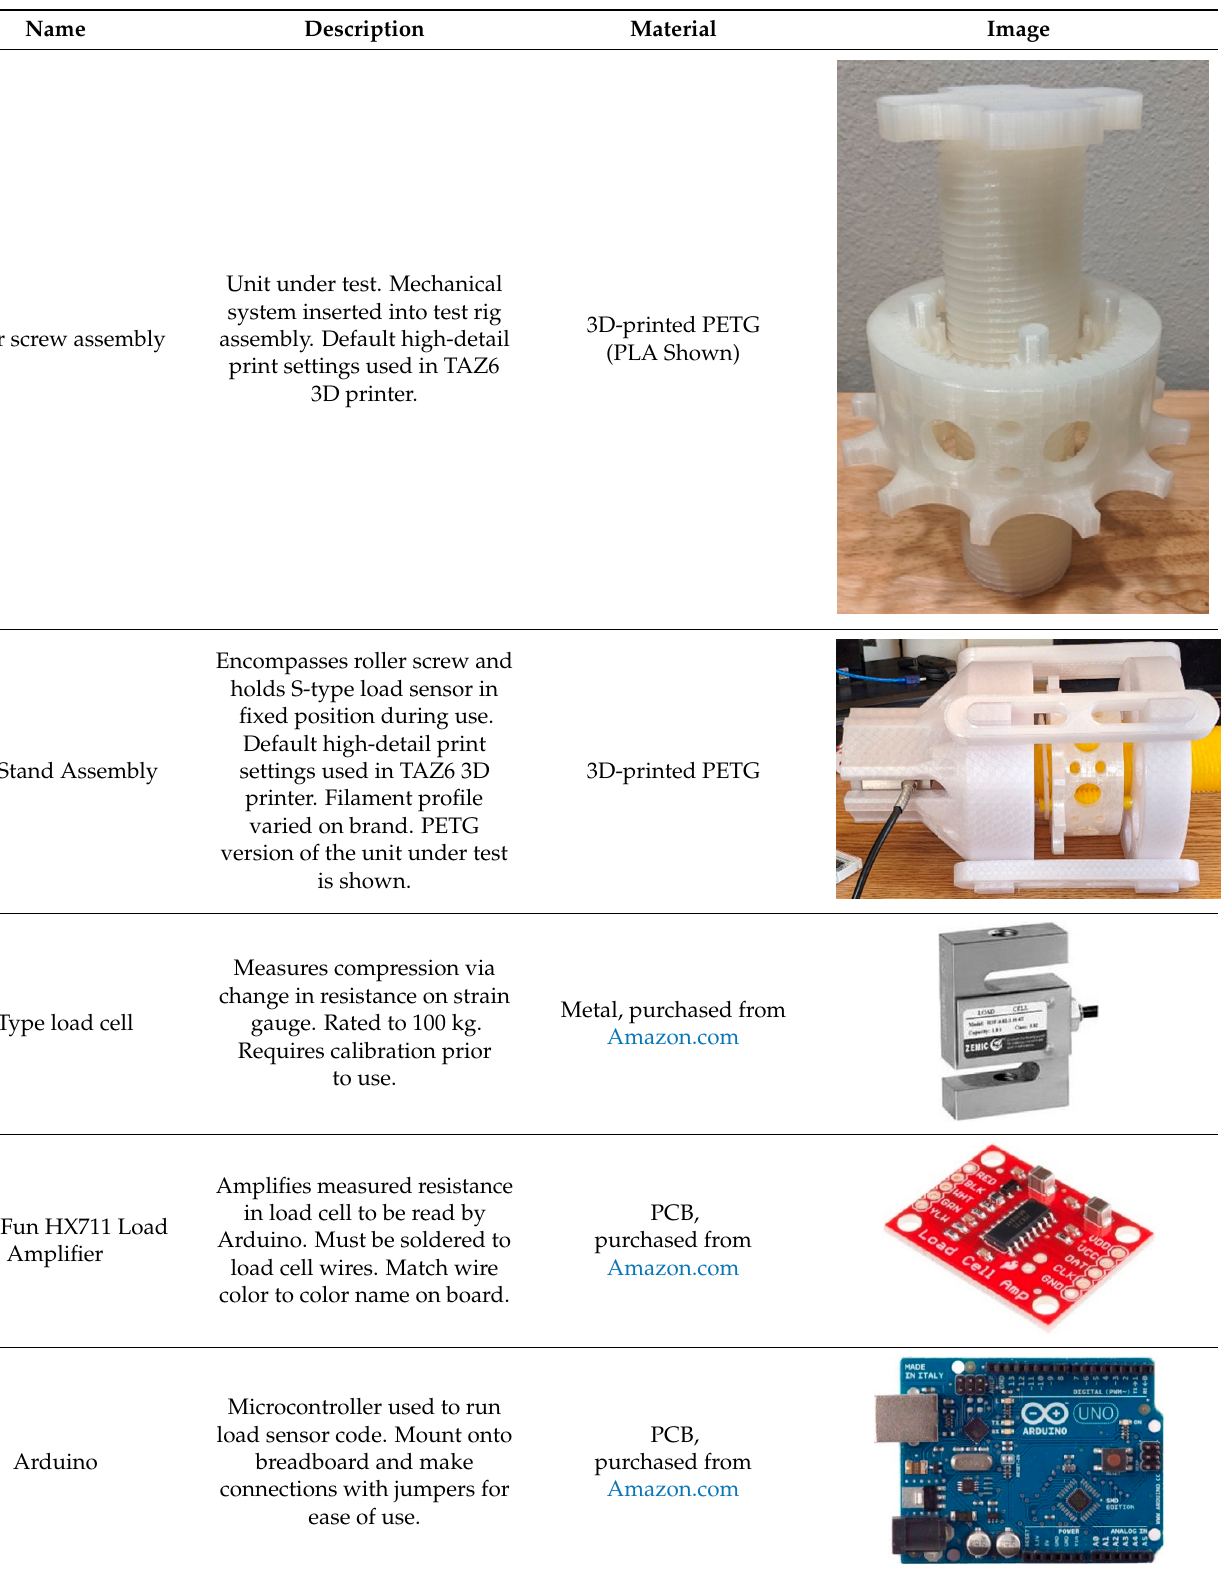
Figure 2. HX711 loadcell wiring diagram, courtesy of sparkfun.com. After connecting all components, then, Arduino was used to calibrate the load cell. The HX711 library was downloaded from the Arduino IDE library manager. The public domain “SparkFun_HX711_Calibration.ino” calibration code was available from the SparkFun website and can alsobe downloaded from the project github repository [62]. A 9.07 kg weight was placed on top of the load cell, and the calibration factor in the calibra- tion code was adjusted until the output on the serial monitor matched the weight. Once the calibration was completed, the calibration factor was placed into the “run_scale.ino”